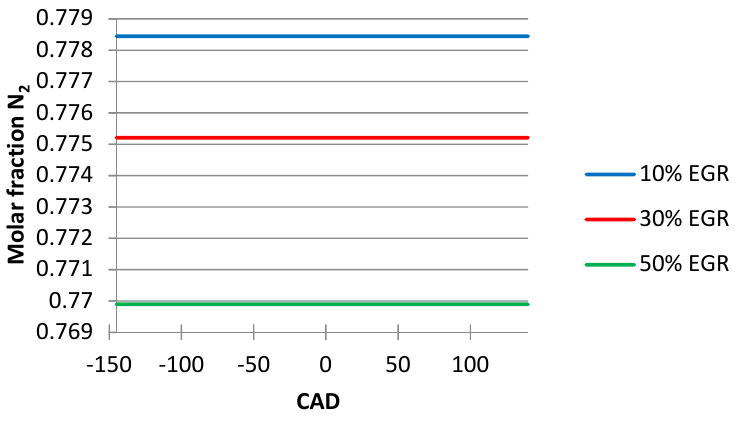
Figure 5. EGR ratio influence on pressure inside the cylinder. In Figure 6, it can be seen that the EGR ratio influences N 2 emissions, and the values obtained of the N 2 emissions decrease with the increase in the EGR ratio at 50%.